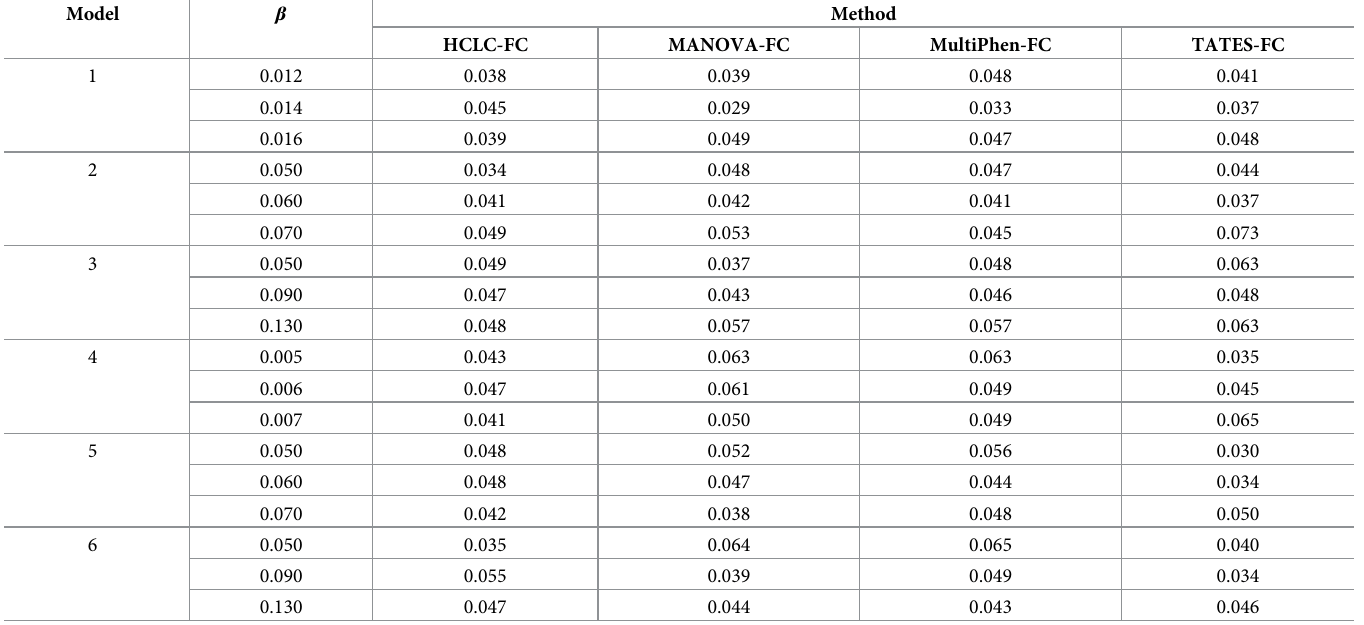
Table 1. The estimated FDR of the four tests under the six models for 1,000 phenotypes ( K = 1,000). MAF is 0.3. The sample size ( n ) is 2,000. ρ = 0.5. β is the effect size. FDR is evaluated using 200 replicated samples at a nominal FDR level of 5%. All estimated FDR are within the 95% confidence interval (0.0198,